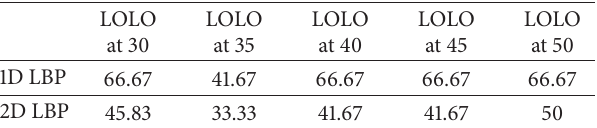
Table 4: The performance of SVM in FSFL model when the 2D LBP scheme is used for feature extraction.